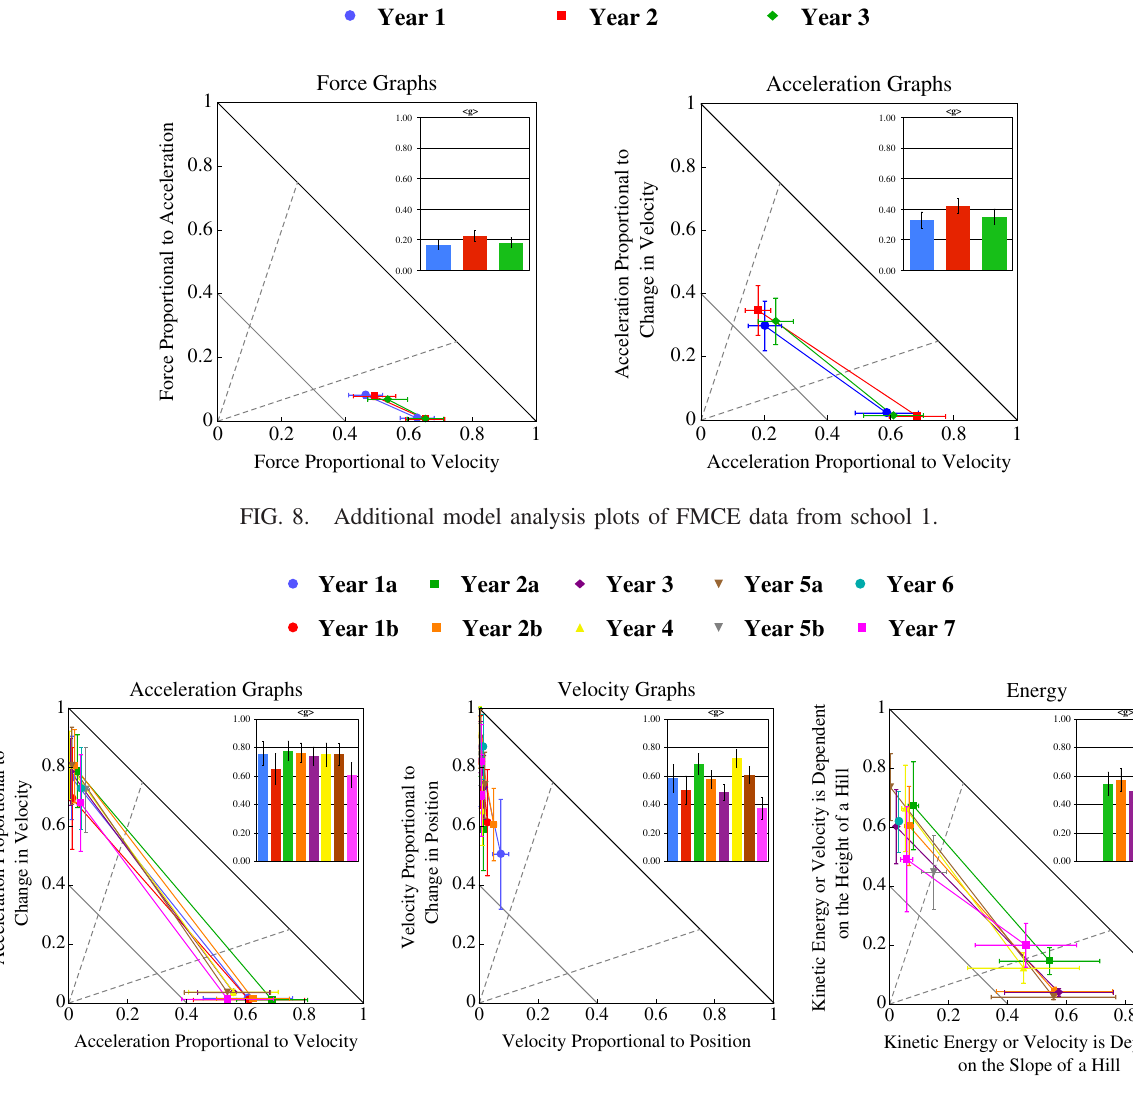
FIG. 9. Additional model analysis plots of FMCE data from school 2.